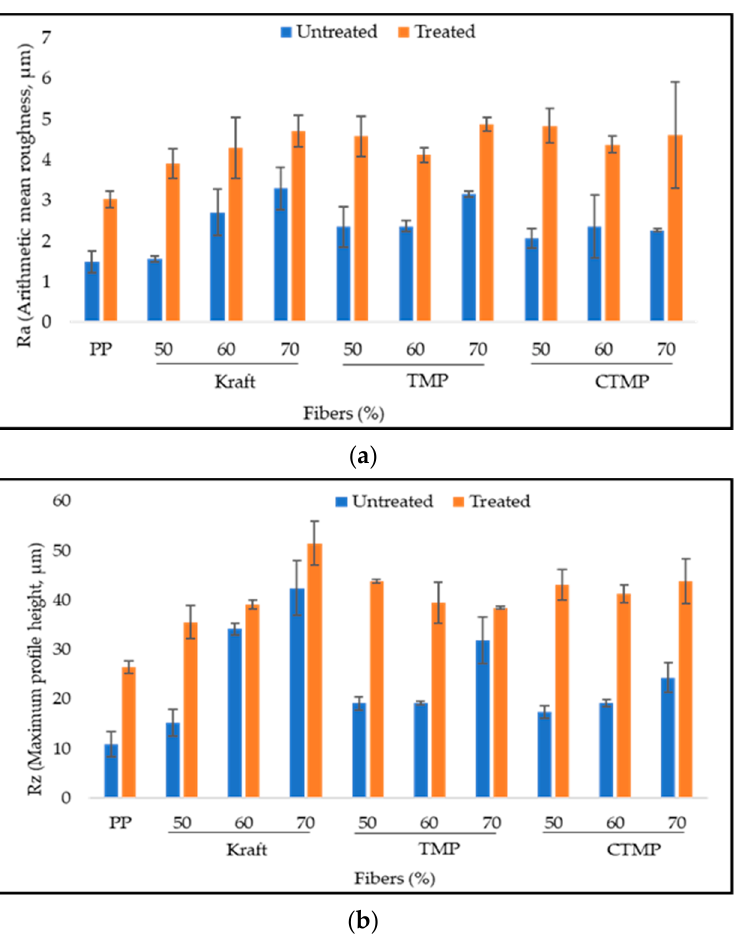
Figure 3. Evolution of profile roughness parameters (2D) of PP-based composites before and after chromic treatment: ( a ) arithmetic mean roughness evolution and ( b ) maximal profile height evolution.